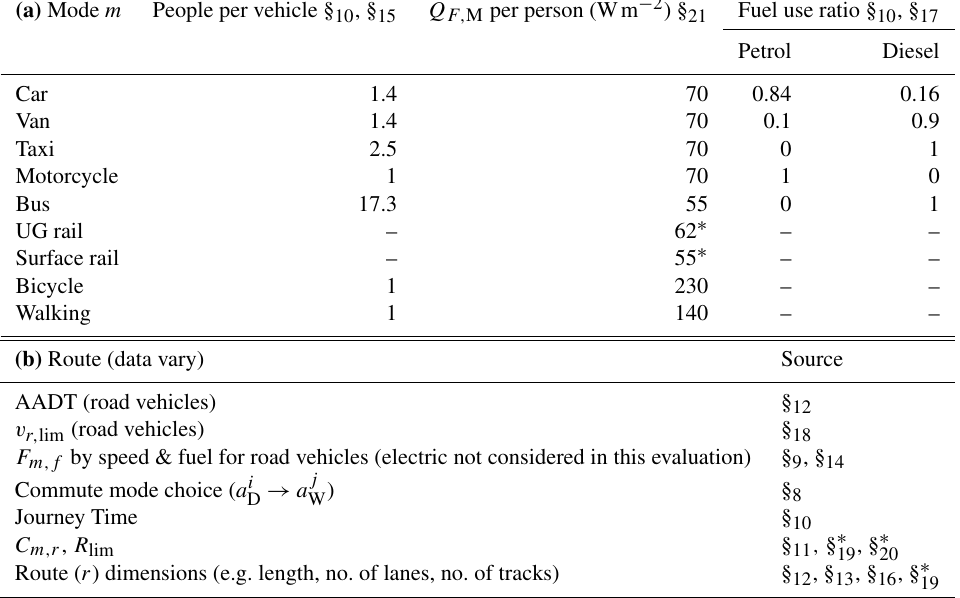
Table 4. Data sources for (a) modes and (b) routes. Variations from data include the following: buses: 85% diesel of fleet (in 2015) and rest mostly hybrid; electric (EV) and low-emission vehicles: EV cars 0.2% of GL registered vehicles (2015) (DfT and DVLA, 2019). Data sources: § 8 – ONS (2014b); § 9 – ONS (2018); § 10 – DfT (2017); § 11 – DfT (2014a, b); § 12 – London Datastore (2014); § 13 – OS (2016); § 14 – Smith et al. (2009); § 15 – Highways Agency (2017); § 16 – TfL (2018); § 17 – TfL (2019); § 18 – OS (2015); § 19 – TfL Train and Underground Rolling Stock Information Sheets from § 10 ; § 20 – TfL working timetables from § 10 ; § 21 – Iamarino et al. (2012). (a) Mode m